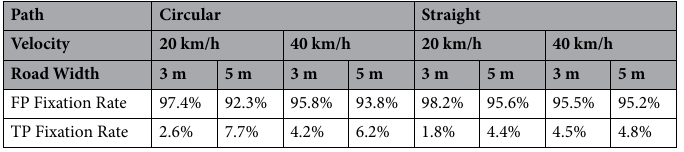
Table 1. Results of average rate of observed drivers’ FP and TP fixations for each condition.